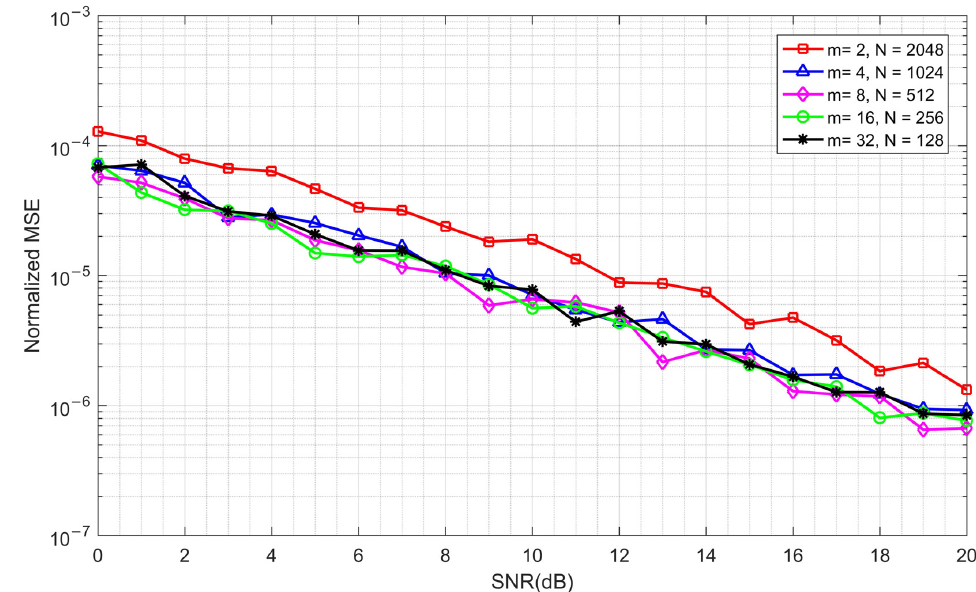
Figure 12. The normalized MSE with di ff erent m and N under a fi xed CFO of 20 kHz.